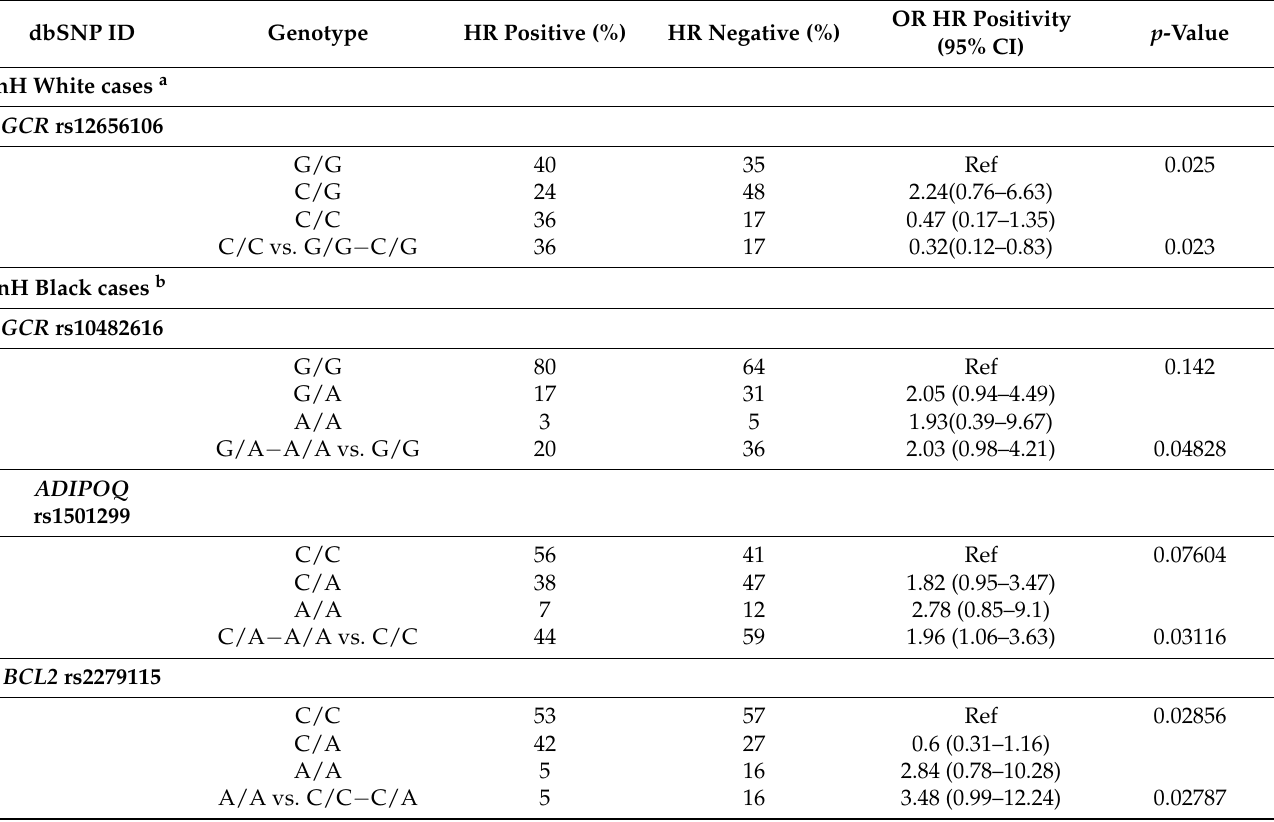
Table 4. List of SNPs with significant association with hormone receptor positivity (ER or PR) ( p < 0.06).